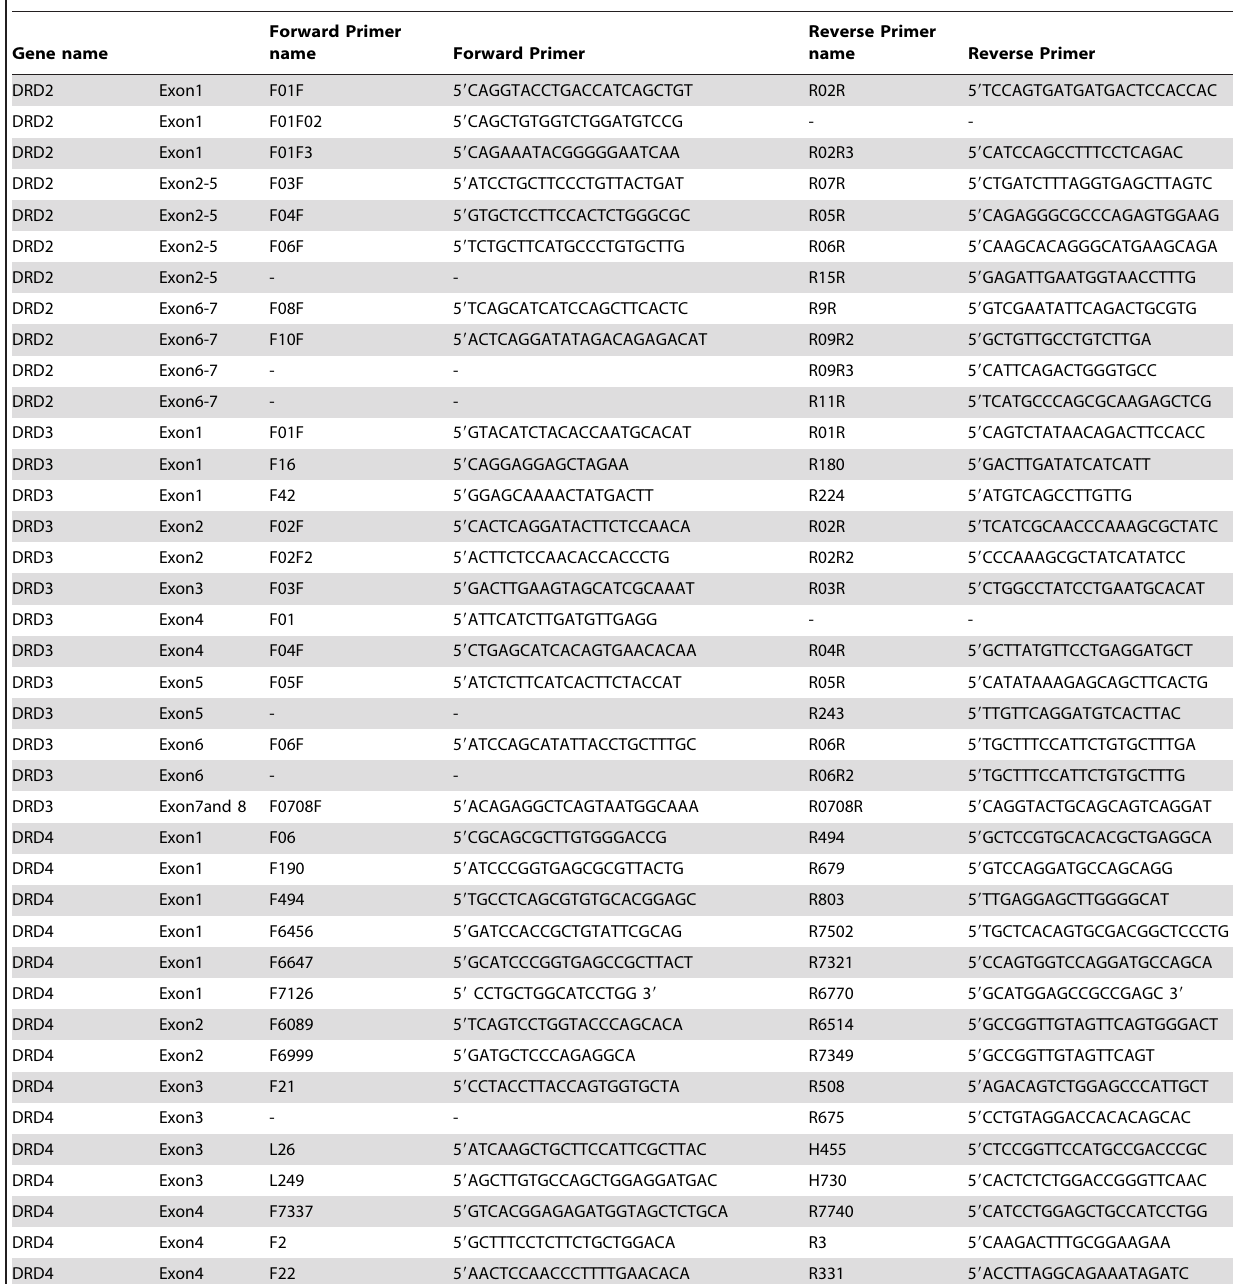
Table 5. Primers used for amplifying the DRD2, DRD3, and DRD4 genes.